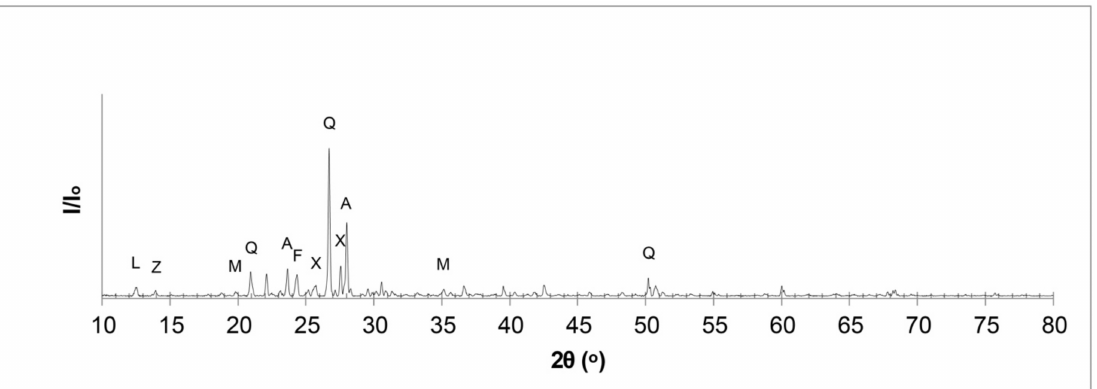
Figure 3. Representative X-ray diffraction pattern showing generalized mineralogy of